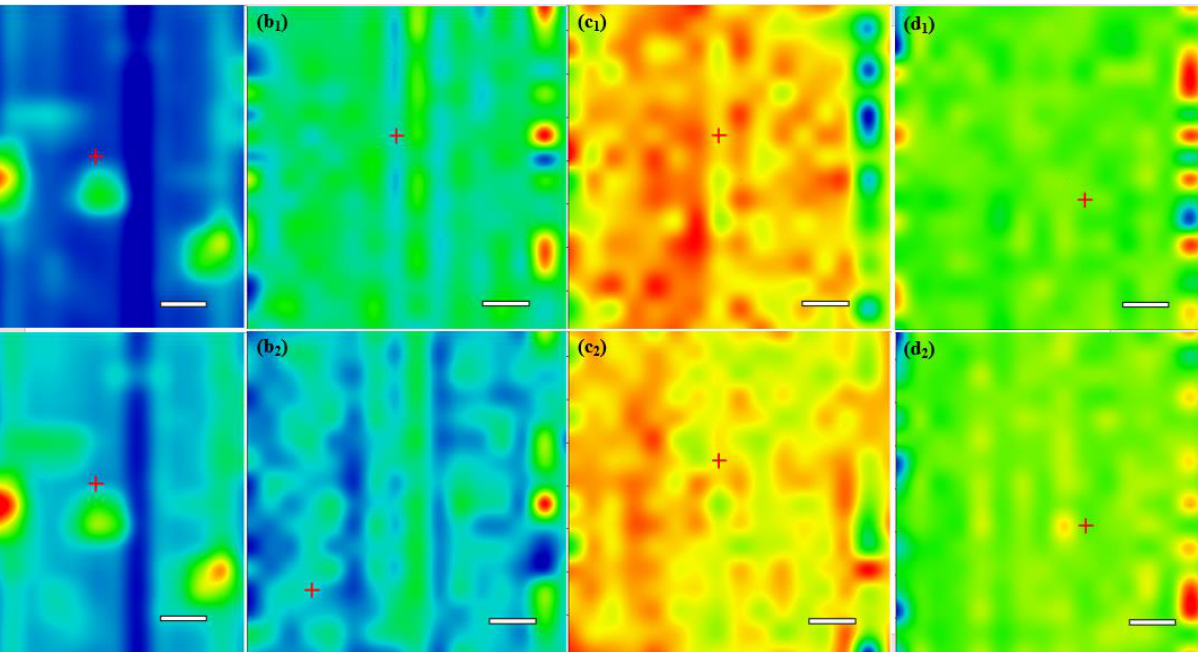
Figure 4. Thermogravimetric analysis of ( a ) Fe 3 O 4 and ( b ) Fe 3 O 4 @CS nanoparticles.